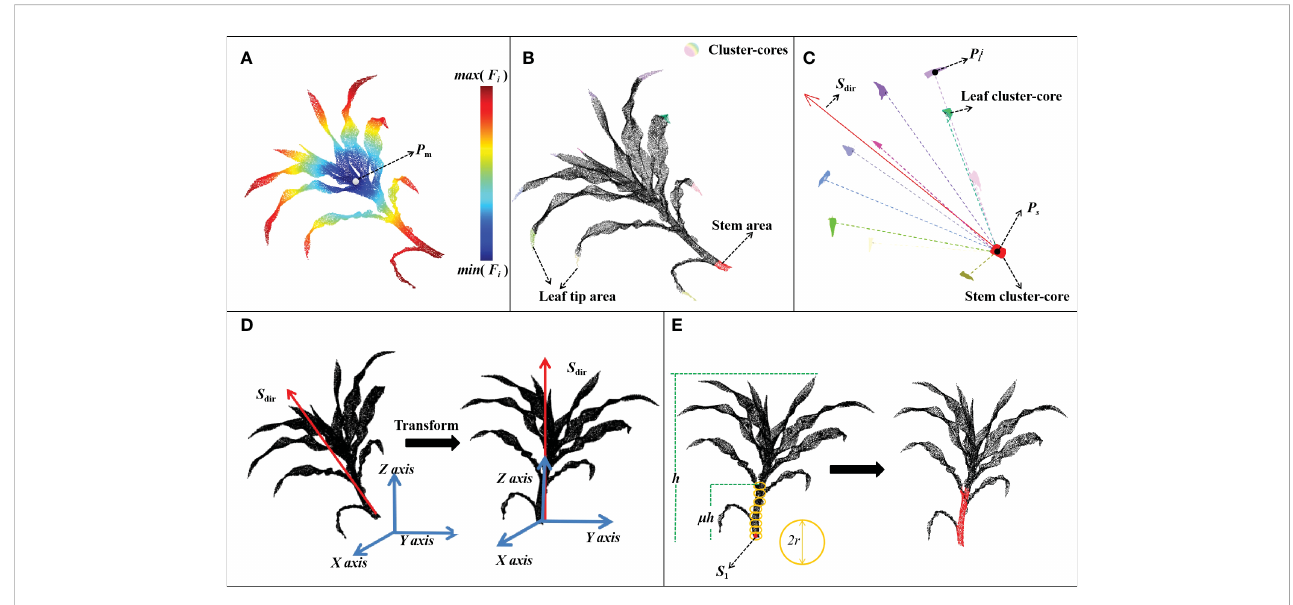
FIGURE 3 Flow chart of the stem segmentation process. (A) A thermodynamic diagram of distance function; (B) Stem region extraction based on DFSP; (C) Estimation of plant growth direction; (D) Plant point cloud alignment; (E) Median normalized growth segmentation of the stem point